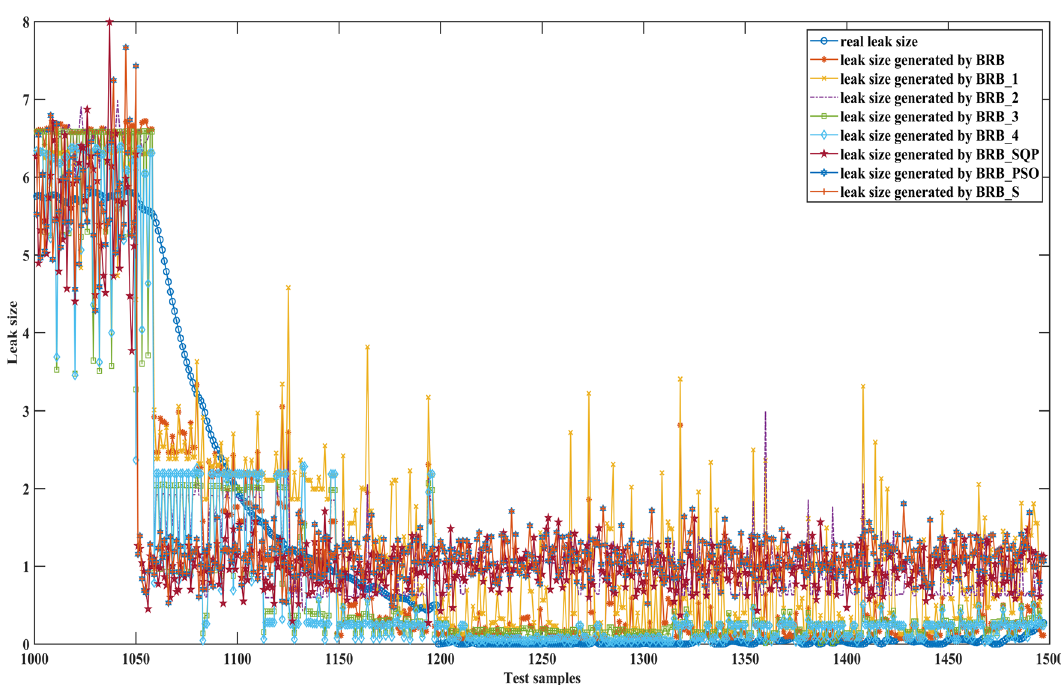
Figure 17. The 1001–1497 comparative results generated by different